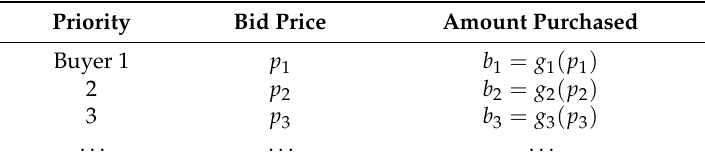
Table 4. Quotations of all buyers in the water